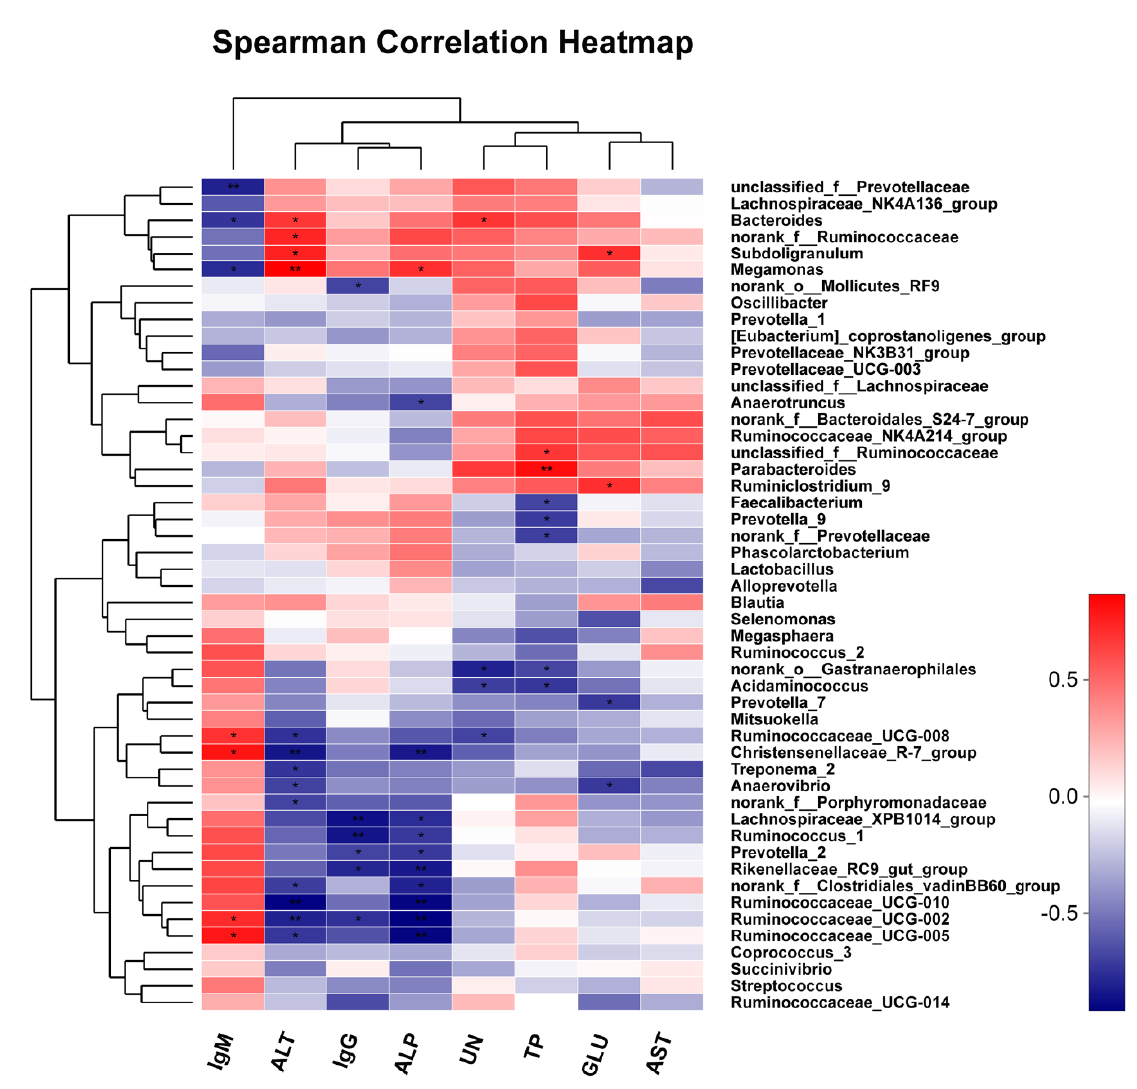
Figure 6. Heatmap of the correlation analysis between the top 50 bacterial genera and the environmental factors. UN: urea nitrogen, GLU: glucose, TP: total protein, IgM: immunoglobin M, IgG: immunoglobin G, ALT: alanine aminotransferase, AST: aspartate aminotransferase, ALP: alkaline phosphatase. * p ≤ 0.05, ** p ≤ 0.01. Group A: basal diet; group B: basal diet supplemented with antibiotics and zinc oxide; group C: basal diet supplemented with 0.06% CPB.